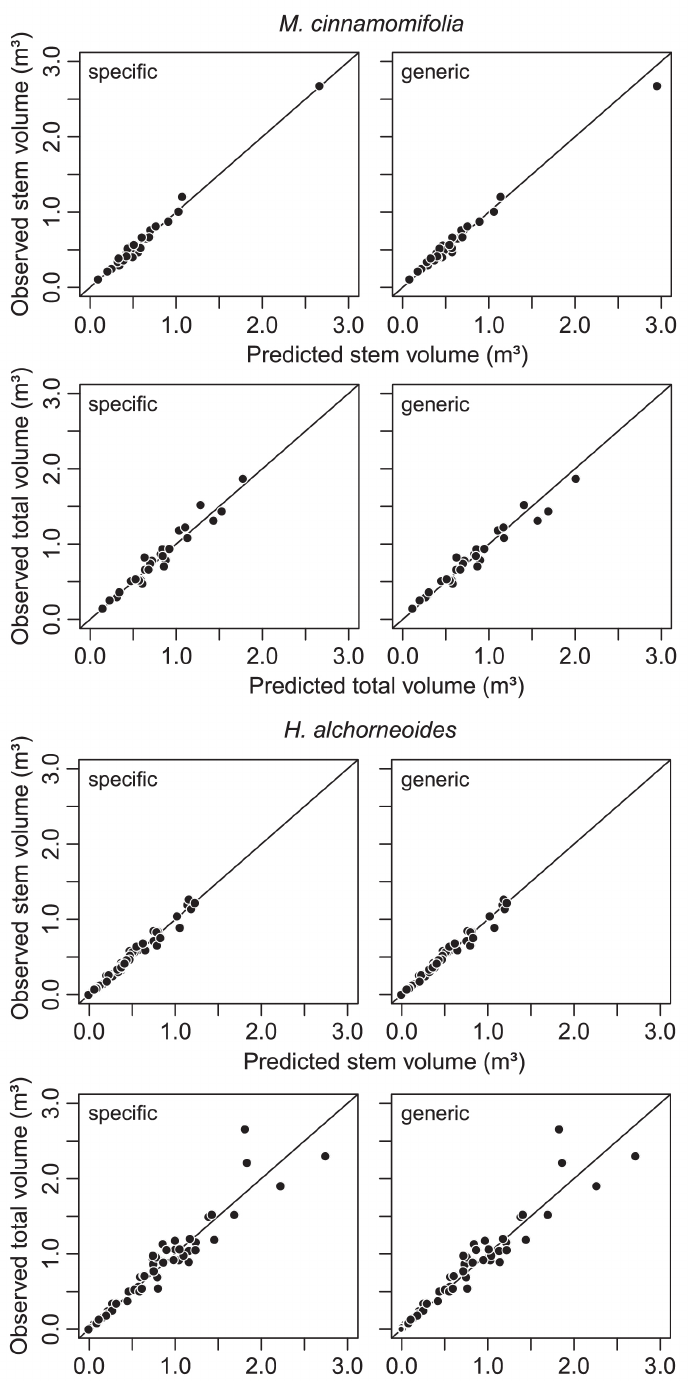
Figure 3 - Observed vs. predicted values generated by the best specific and generic stem and total tree volume models for M. cinnamomifolia and H. alchorneoides